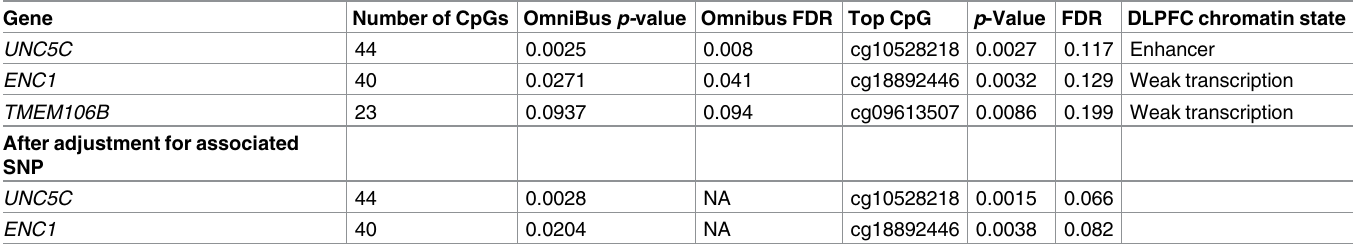
Table 3. Association of differential DNA methylation patterns with residual